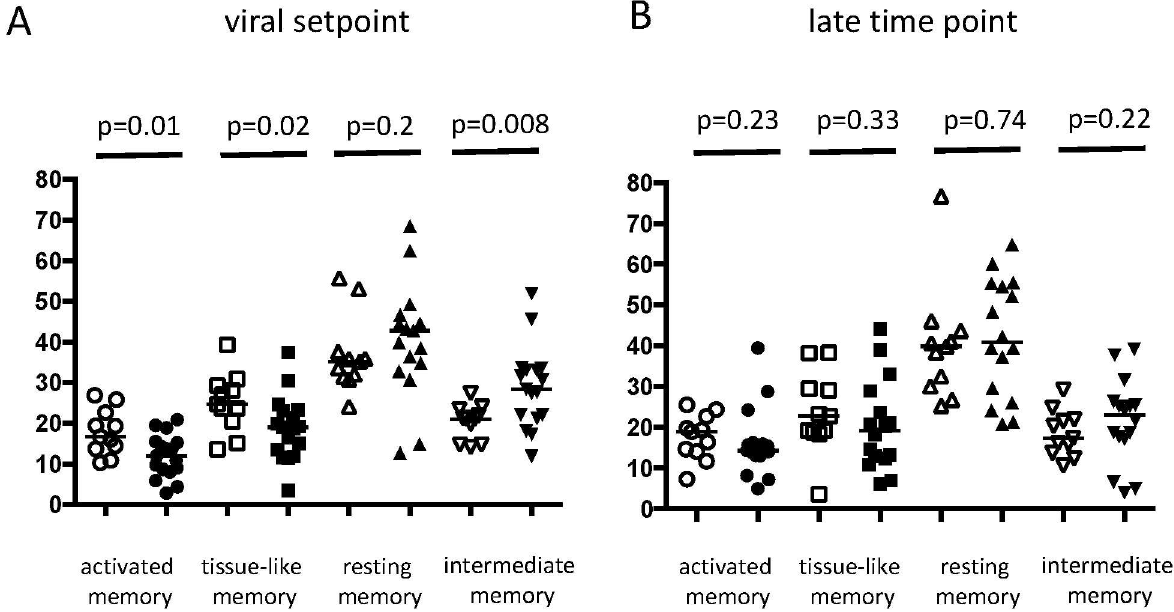
Fig 3. Differences in phenotype of the B cell compartment at viral setpoint (A) and the late time point (B) between untreated (empty symbols) and treated (filled symbols) patients. Scatterplots show the frequency of memory B cells dividedby subset. Horizontalbars represent medianvalues and statistical significancewas calculatedusing the nonparametric Mann-Whitney U test. Open symbols represent untreated patients and closed symbols represent treated patients. On the y-axis percentages of cells are depicted gated on aqua neg CD19 pos IgG pos